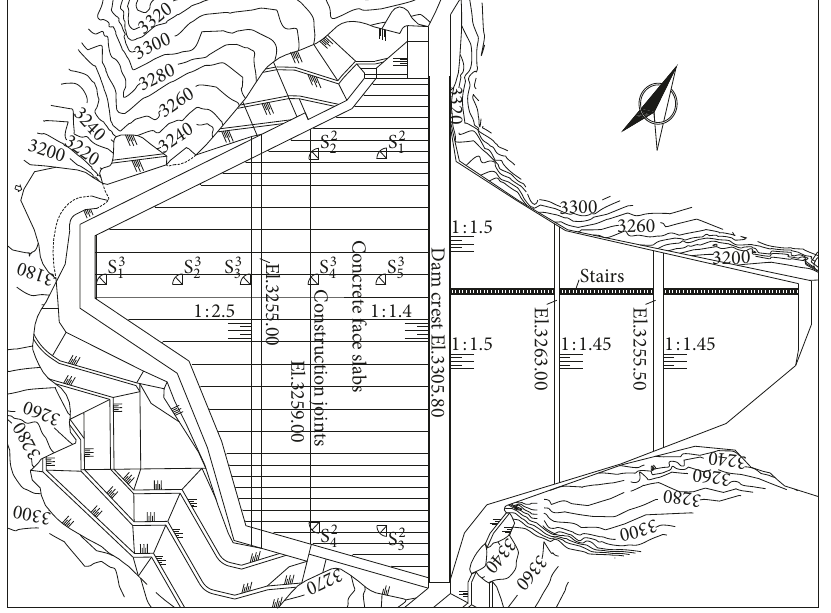
Figure 3: Dam plan layout and concrete-face rebar meter layout.